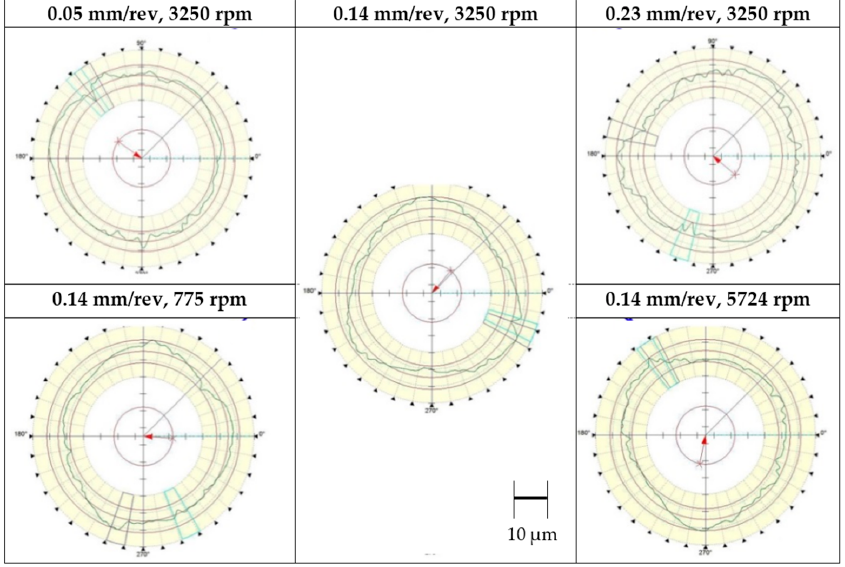
Figure 10. Hole roundness profiles in the middle of the holes.